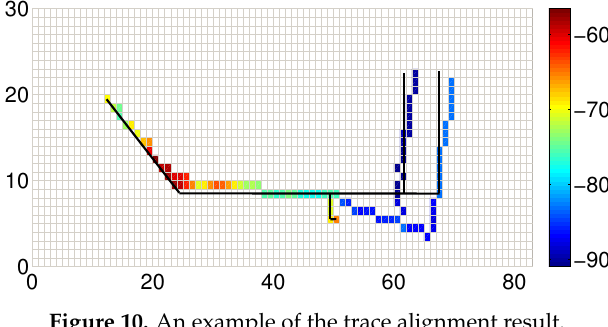
Figure 10. An example of the trace alignment result.